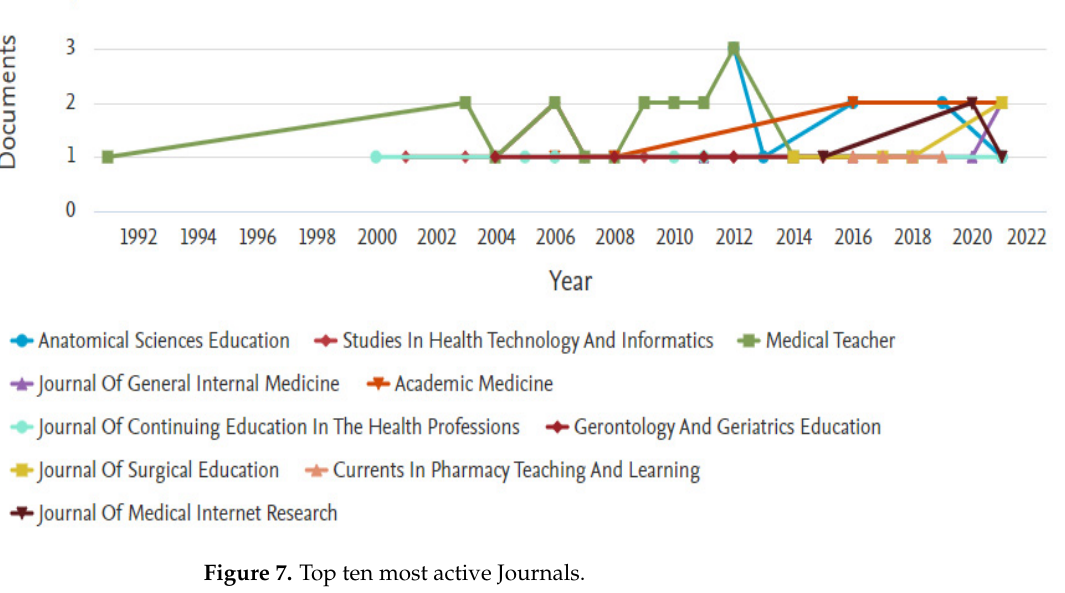
Figure 7. Top ten most active